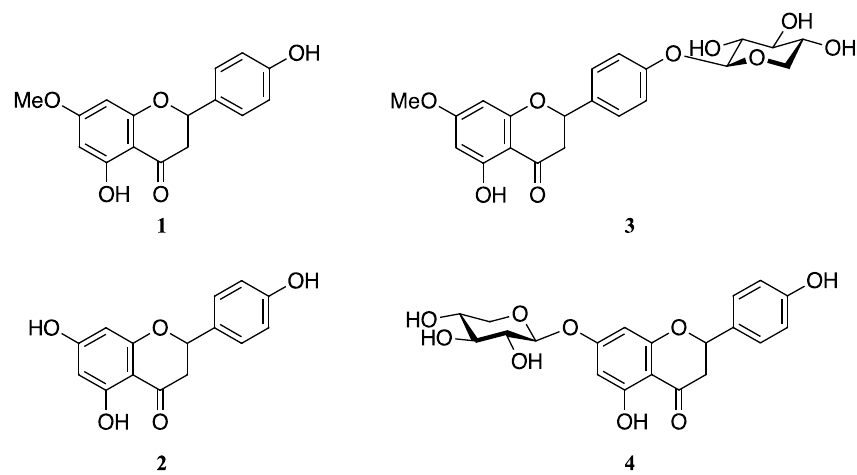
Figure 1. Structures of sakuranetin ( 1 ), naringenin ( 2 ), sakuranetin-4 ′ - O - β - D -xylopyranoside ( 3 ), and naringenin-7- O - β - D -xylopyranoside ( 4 ).